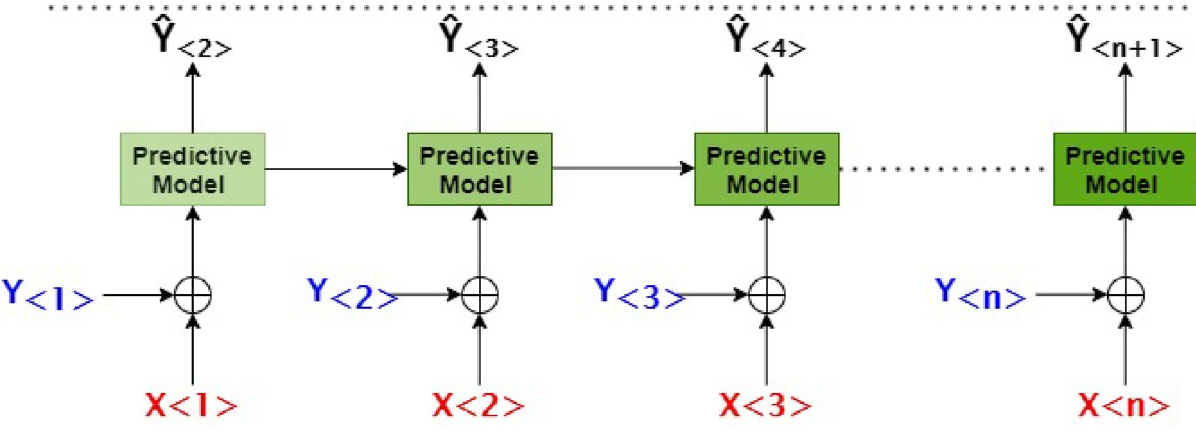
Figure 1. Block diagram of the problem